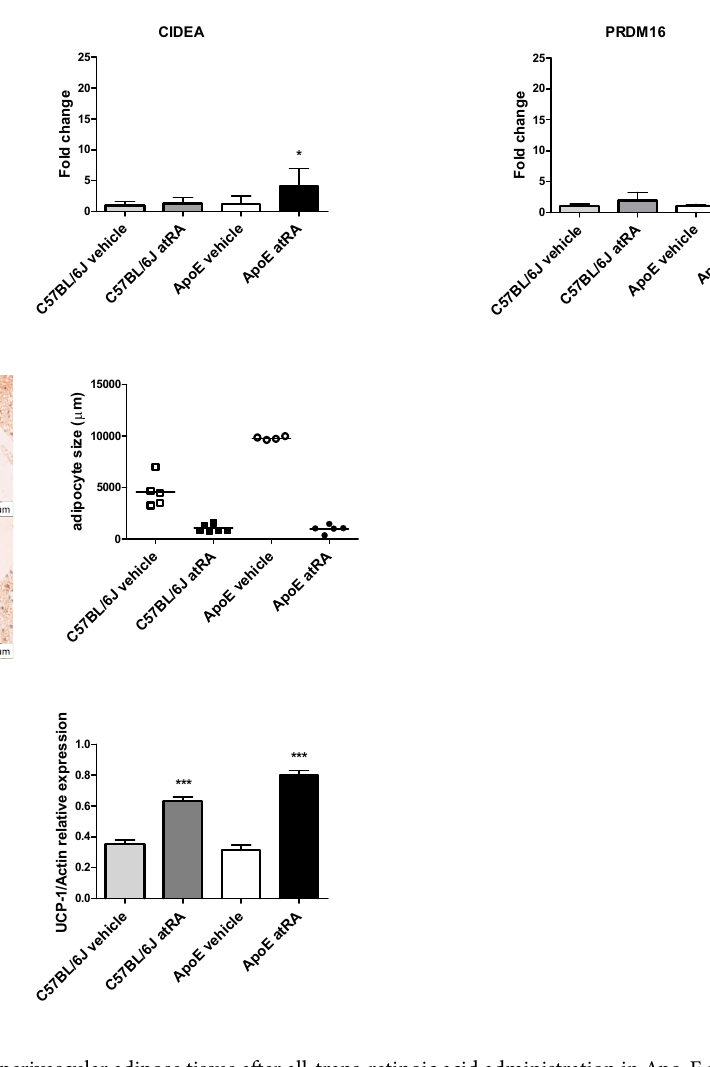
Figure 3. Browning of perivascular adipose tissue after all-trans-retinoic acid administration in Apo-E mice. ( A ) Adipose thermogenic gene expression: Ucp1 , Cidea , and Prdm16 . ( B ) Perivascular adipose tissue UCP1 immunohistochemical staining. ( C ) UCP1 protein expression was determined by Western Blot. All-trans- retinoic acid (5 mg/kg/day) or vehicle (corn oil) was administered orally by plastic feeding tubes to Apo-E and C57BL/6J mice for 8 weeks. Data are shown as mean ± SEM of 5–6 mice per group. The results were analyzed by one ‐ way ANOVA with Tukey’s Multiple Comparison Test. *p < 0.05 C57BL/6J atRA vs. C57BL/6J vehicle, ApoE atRA vs. ApoE vehicle; **p < 0.01 ApoE atRA vs. ApoE vehicle; ***p < 0.001 C57BL/6J atRA vs. C57BL/6J vehicle, and ApoE atRA vs. ApoE vehicle. Full-length blots are presented in Supplementary Fig.